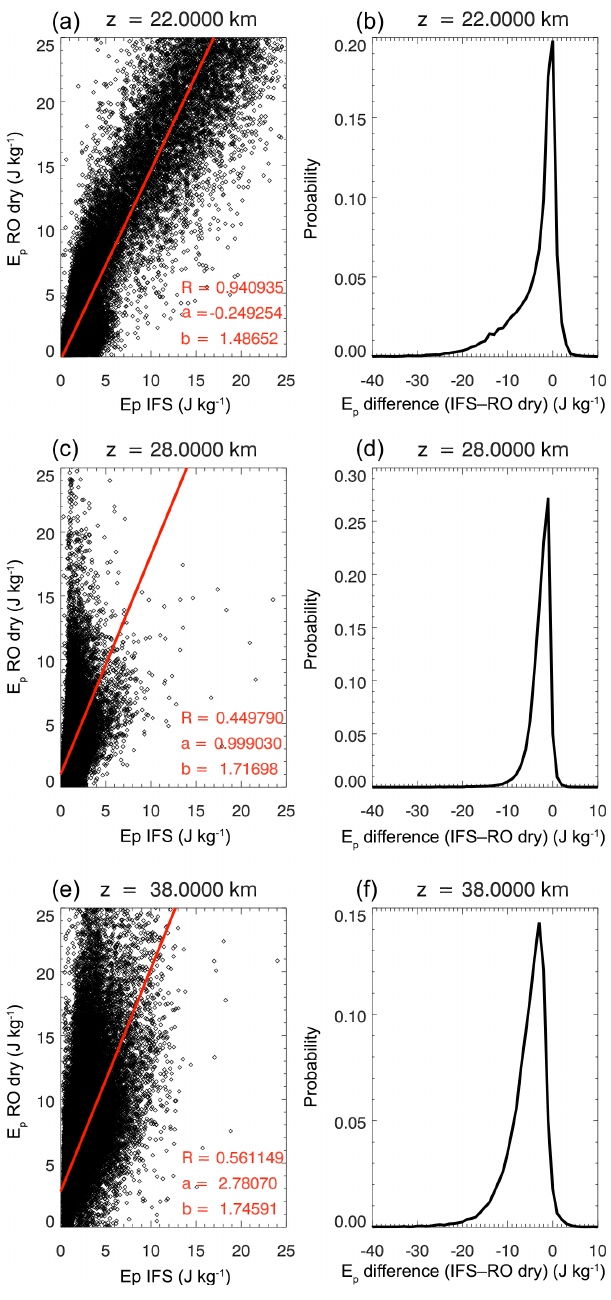
Figure 9. (a, c, e) Scatter plots between E P values derived from the IFS and RO-dry data for three different altitudes, i.e., 22km (a, b) , 28km (c, d) , and 38km (e, f) . The red line shows a linear fit to the data with slope b, y intercept a, and correlation coefficient R (see insert). (b, d, f) Corresponding histograms of the difference between the two data